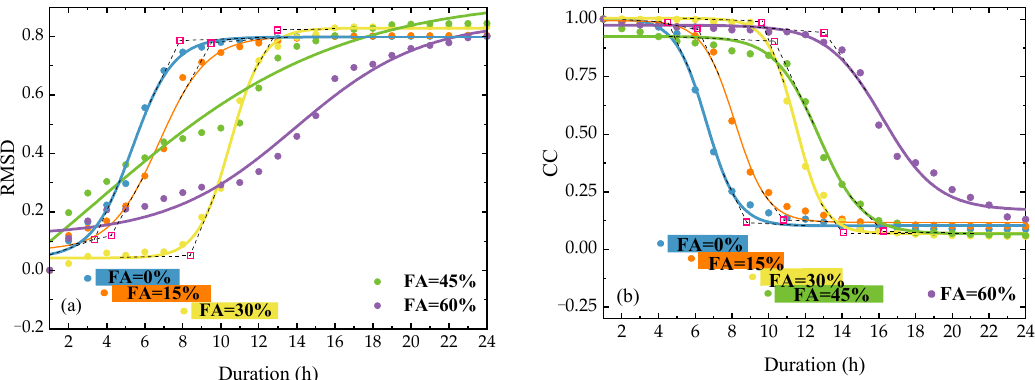
Figure 8. Statistical metrics (RMSD and CC) for SCC specimens with different FA replacement ratios during curing.